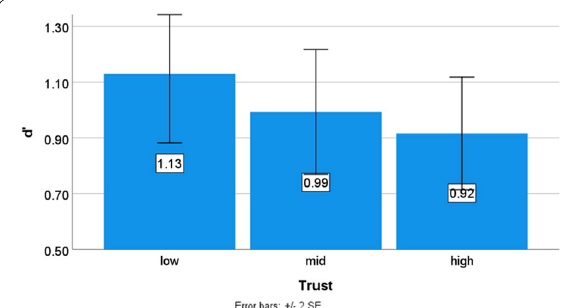
Fig. 5 Average authentication sensitivity scores per condition of trust in the authenticity of a banknote (low, mid, high). Presentation time is until response. The sensitivity scores of participants significantly changed when the expectancy of the ratio of counterfeits was varied. Error bars depict 95% confidence intervals